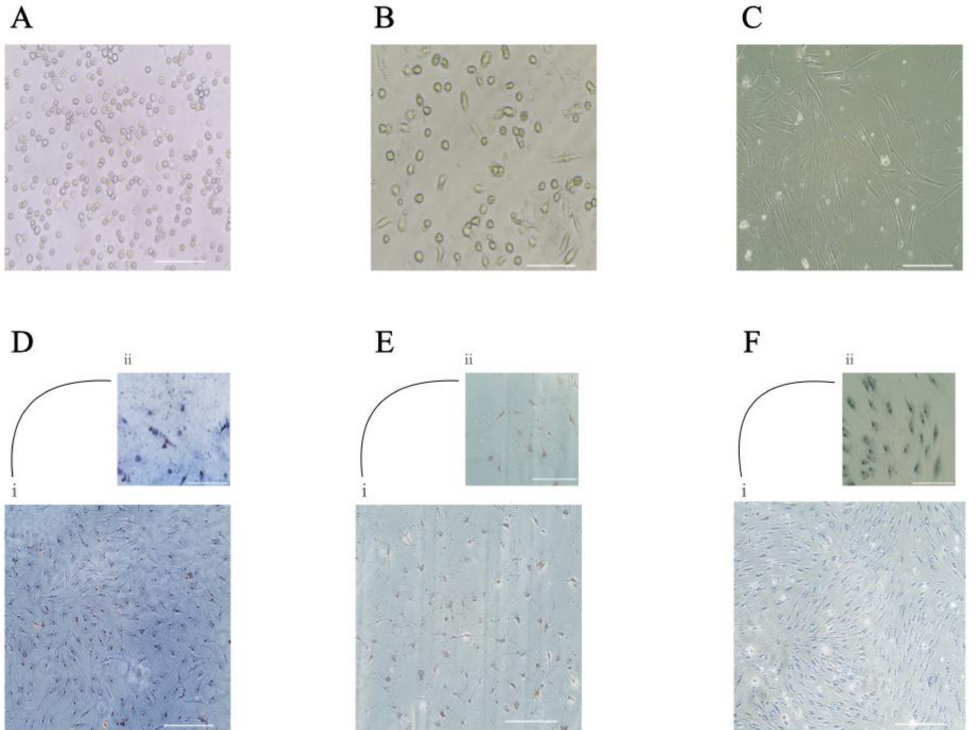
Figure 1. Isolation and culture of circulating BMMPs. Freshly isolated Buffy-coat ( A ), adherent BMMPs showed their characteristics to form colonies ( B ), and their spindle-shape figure ( C ). Photos refer to day 0 ( A ) and to day 4 ( B ) and day 15 ( C ) of the primary culture. Scale bar = 50 µ m ( A – C ). BMMPs showed an ability to differentiate into adipocytes ( D i,ii), osteocytes ( E i,ii), and chondrocytes